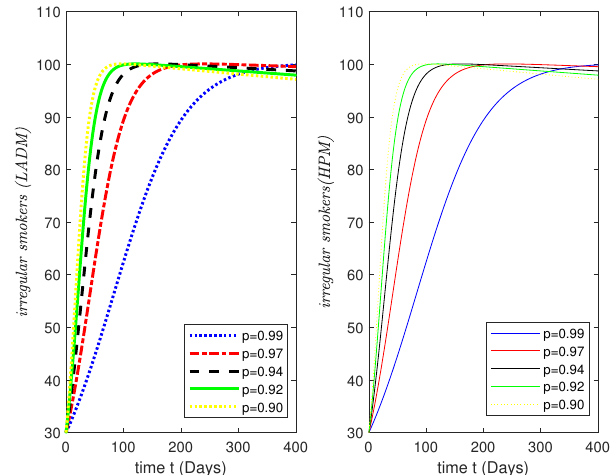
Figure 9. Comparison of the approximate solution for J ( t ) class of the proposed model at different arbitrary fractional orders by LADM and